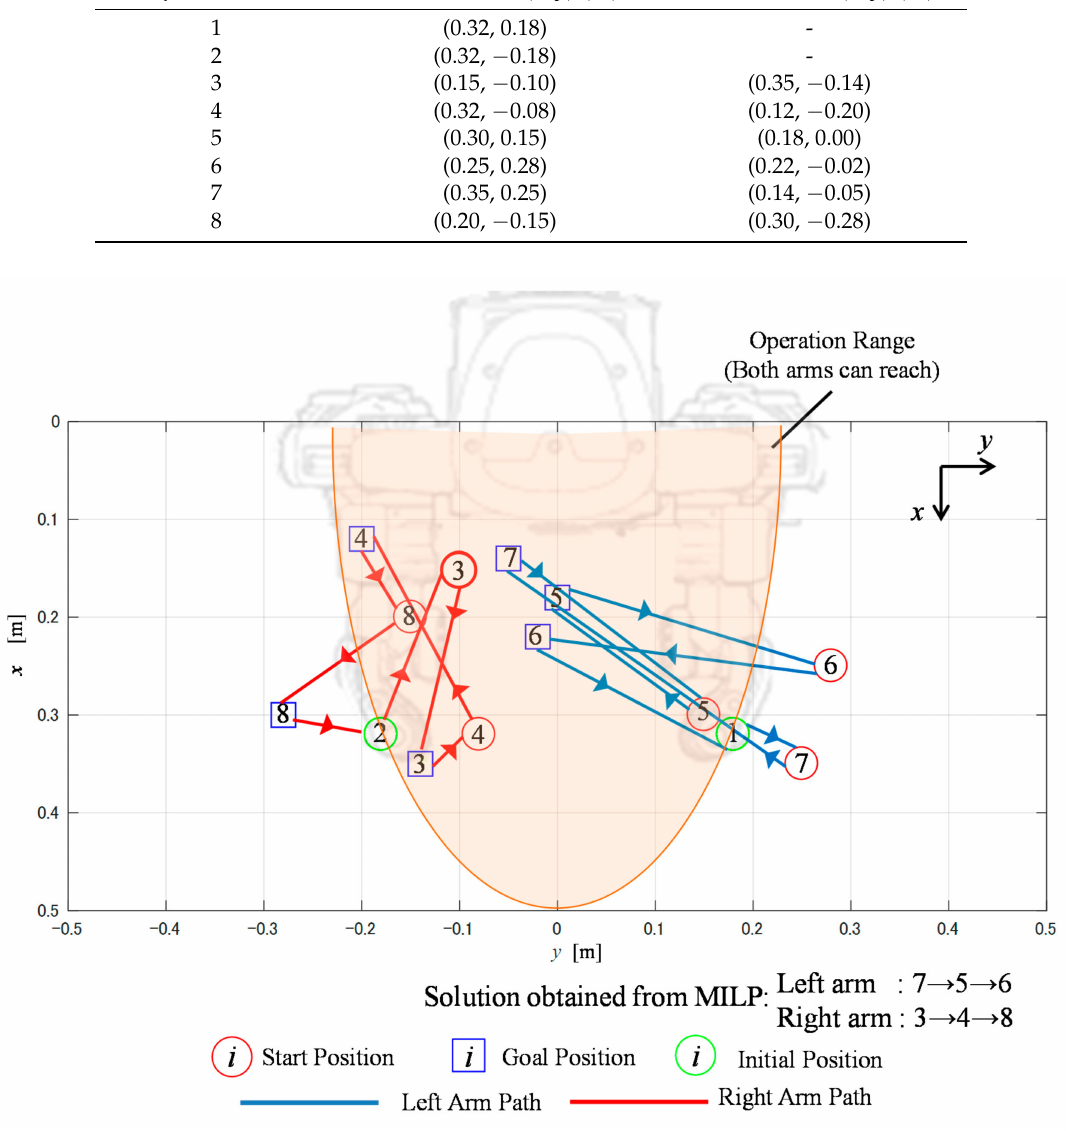
Figure 8. Solution obtained by the proposed method in Experiment